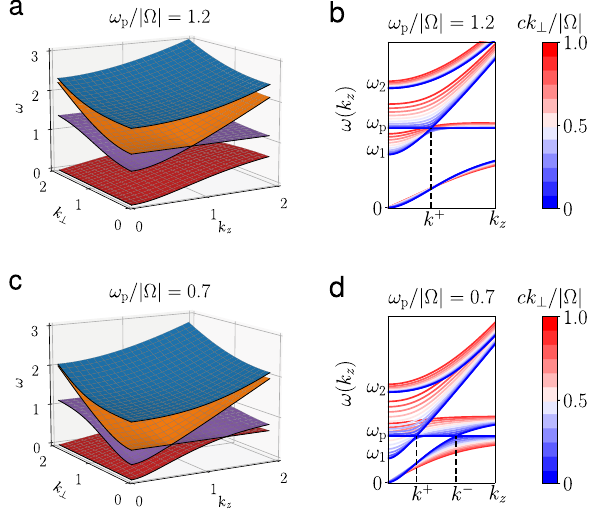
Fig. 1 Dispersion relations of magnetized cold plasmas. a Dispersion relation surfaces of an overdense plasma. Only the k ⊥ > 0 and k z > 0 part of positive-frequency branches are shown. Different colors represent different branches. b The dispersion curves ω ( k z ) at fi xed k ⊥ of an overdense plasma. The colors represent different values of k ⊥ . Only the crossing of the curves with the same color indicates the crossing of different branches. ffiffiffiffiffiffiffiffiffiffiffiffiffiffiffi p ω = j Ω j ¼ ð 4 r 2 þ 1 ± 1 Þ = 2, where r = ω p / ∣ Ω ∣ . k ± are given by Eq. (4) 1 ; 2 assuming Ω > 0. ( c ), ( d ) Same as ( a ), ( b ) but for an underdense plasma.